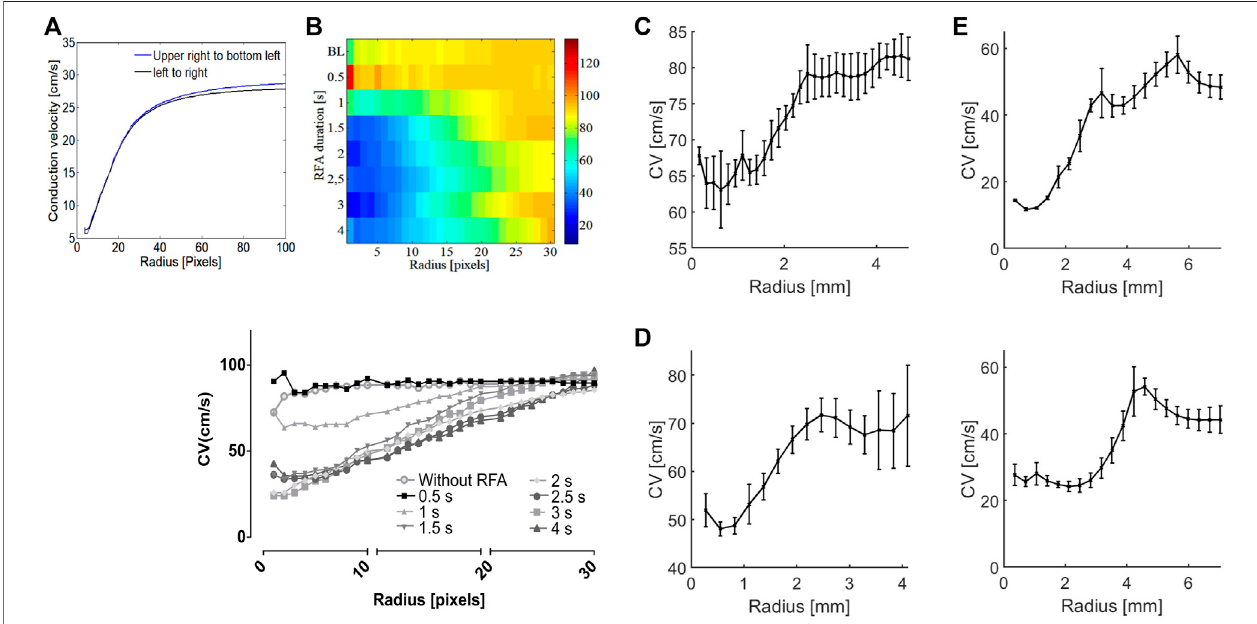
FIGURE7| EstimationoftheablatedareasizebasedontheCMradius. (A) Innumericalsimulations,CVlinearlyincreaseswithCMradiusinsidetheablatedareaof 20pixelsinradius,reachingalimitvalueoutsidetheablatedarea.Theablatedarearadiuscanbeestimated asadeviation,thekneepoint,fromalinearrise,independent ofwavefrontdirection. (B) HeatmapofCVvaluesattheablatedareacenterofratatriaasafunctionofRFAdurationandCMradius.Theheatmapshowstheexpansionof the ablated area with each subsequent ablation step characterized by distinctive CV slowing. (Bottom) CV curves are shown for different RFA steps, with a knee pointfortheapproximateradiusof25pixels,or2 mm. (C) Wholeisolatedguineapigheart.TheCVcurveatthecenterofablation(RFAof3 s)fordifferentCMradii fl attens for an approximate radius of 2.5 mm, indicating an RFA-created lesion of 5 mm diameter. (D) Human heart epicardium of LV. From the fi gure, the CV curve, obtained in the same fashion, fl attens for an approximate radius of 1.5 mm. (E) Human heart endocardium of LV. Upper, for deep-red light excitation, the CV curve fl attens for an approximateCMradiusof2.5 mm,andCMradiusof4 mmforgreenlightexcitation(lower fi